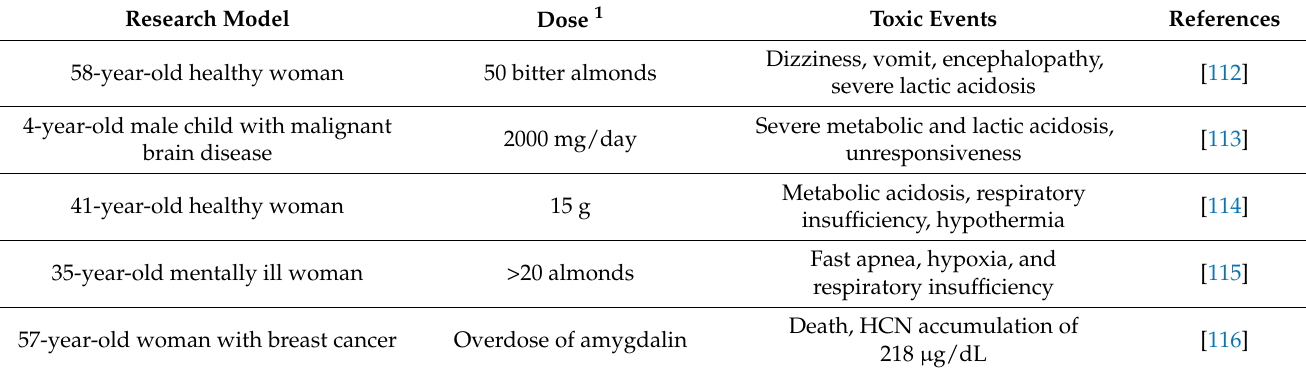
Table 4. Toxigenic effects of amygdalin upon oral